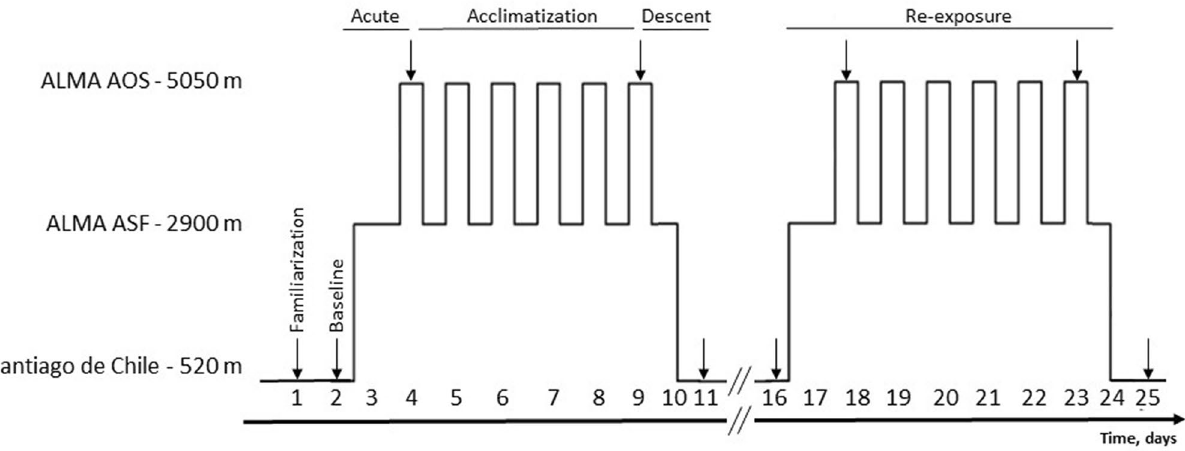
Figure 1. Study design. After a familiarization session at Santiago de Chile (520 m), participants underwent baseline assessments the day preceding travelling to high altitude. Participants travelled to the ALMA Operations Support Facility (ASF—2900 m) and stayed for one night before beginning daily sojourns to the Array Operations Site (AOS—5050 m). Participants alternated between 2900 m (sleeping) and 5050 m (up to 8 h/day). After a one-week recovery period at 520 m, participants performed a second, identical altitude cycle. Arrows indicate experimental testing days and headings indicate the condition of